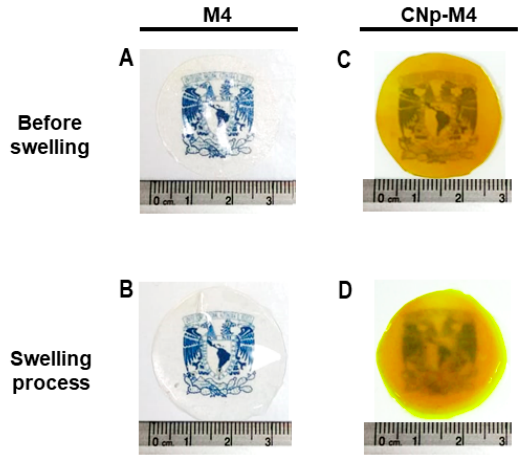
Figure 6. Alginate membranes (M4) before swelling and during the swelling process in PBS medium ( A and B , respectively), and alginate membranes with curcumin nanoparticles (CNp ‒ M4) before swelling and during the swelling process in PBS medium ( C and D , respectively). Scale in